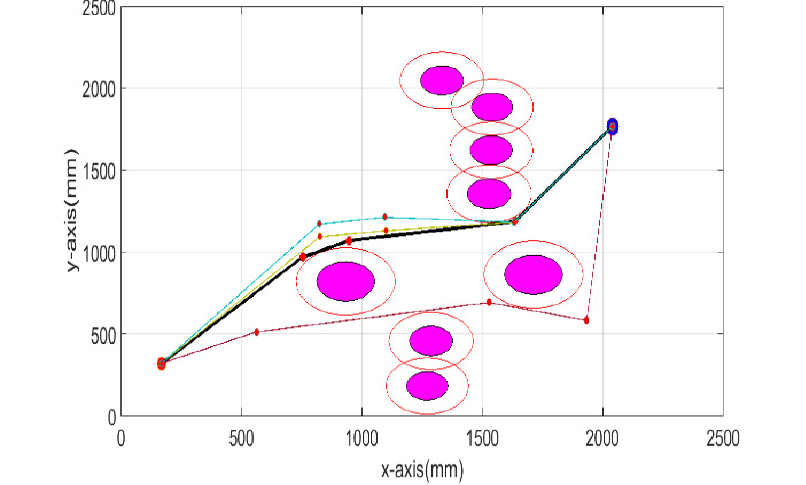
Fig. 14. Path Found by GWO Algorithm for Case 2.